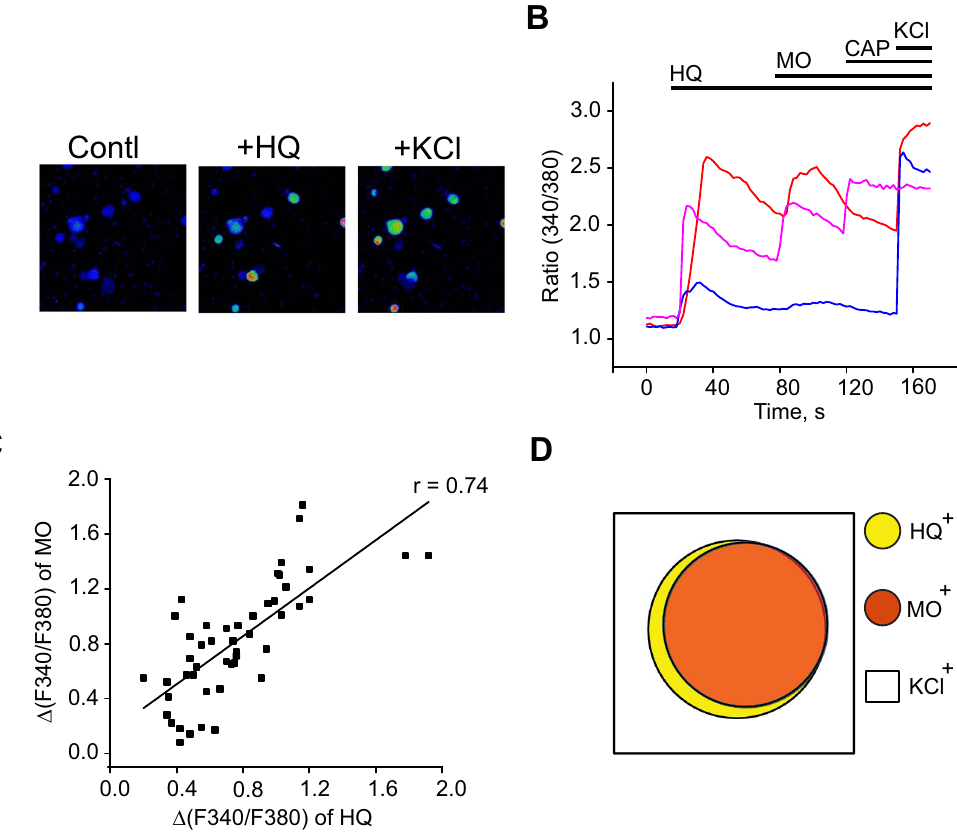
Figure 4. HQ triggers Ca 2 + responses in mouse sensory neurons. ( A ) Representative pseudo-color images of the effect of HQ (30 µ M) on intracellular Ca 2 + of cultured mouse DRG neurons. ( B ) Representative Ca 2 + imaging traces showing the effect of HQ on cultured mouse DRG neurons. The neurons were first challenged with HQ (30 µ M) and subsequently with mustard oil (MO, 100 µ M), capsaicin (CAP, 200 nM) and KCl (40 mM). ( C ) The correlation of the magnitude of HQ- and MO-induced intracellular Ca 2 + signal in mouse DRG neurons (r = 0.74 and P < 0.000001, Pearson correlation, n = 49 neurons). ( D ) Venn diagram showing the overlap of neuronal populations responding to HQ, MO and Cap in mouse DRG neurons. Size and overlap of populations are indicated by circles drawn to the actual scale. 67, 57 and 156 neurons are included in HQ + , MO + and KCl + groups,